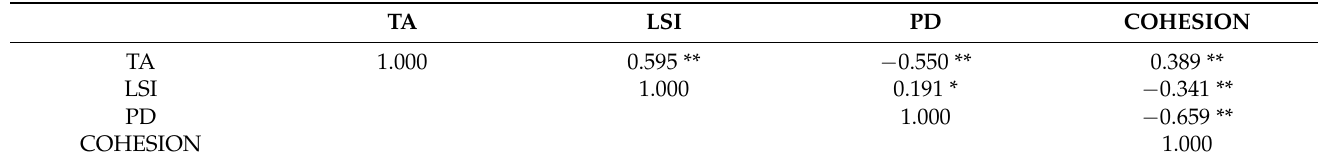
Table 4. Spearman correlation coefficients among the representative landscape